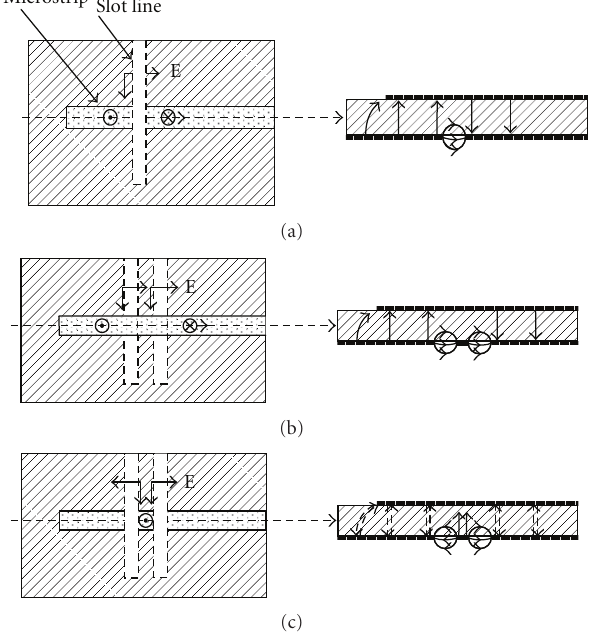
Figure 4: Slot line to microstrip transition, (a) single slot line, (b) paralleled slot lines with equivalent and in-phase fields, and (c) paralleled slot lines with equivalent and out-of-phase